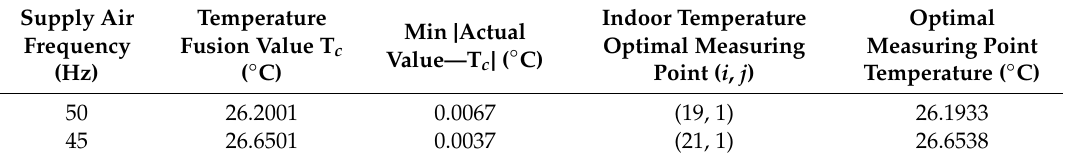
Table 12. Data fusion results.